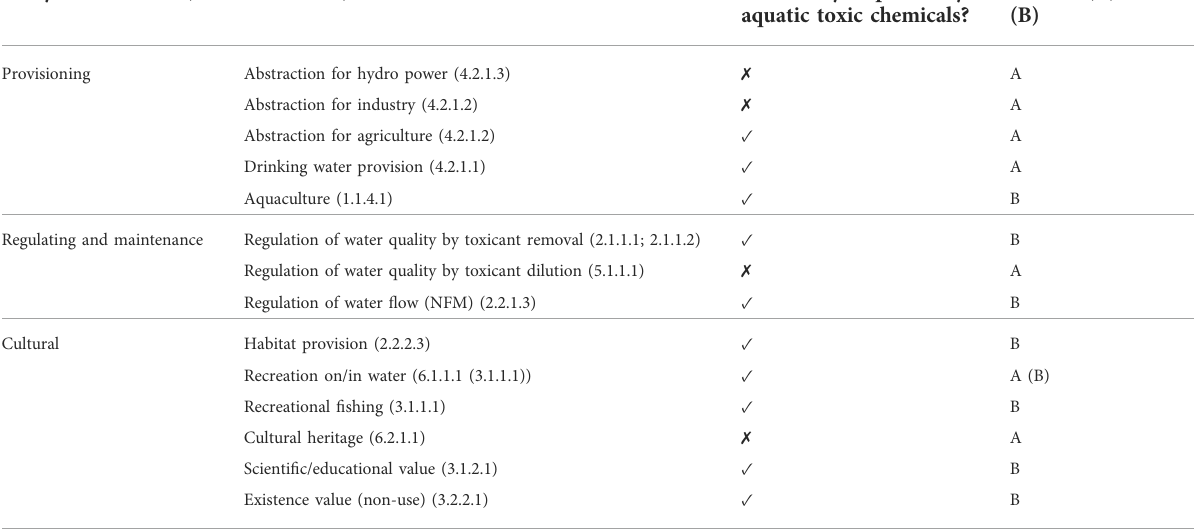
TABLE 1 An illustrative screening of freshwater ecosystem services. Ecosystem services are classi fi ed as ‘ Provisioning ’ , ‘ Regulating and maintenance ’ and ‘ Cultural ’ .EcosystemserviceclasscodesarefromCICESv5.1andarethebasisfordecidingwhetherecosystemservicesareclassi fi edasbiotic or abiotic. The list of ecosystem services is adapted from Spray and Blackstock (2016). NFM is natural fl ood management. Ecosystem services (CICESv5.1 code)